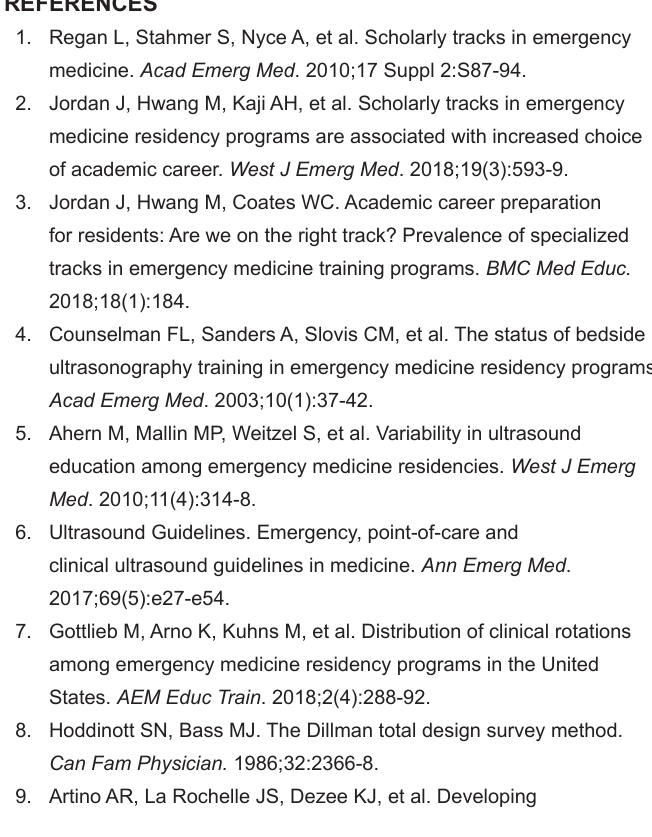
IQR , interquartile